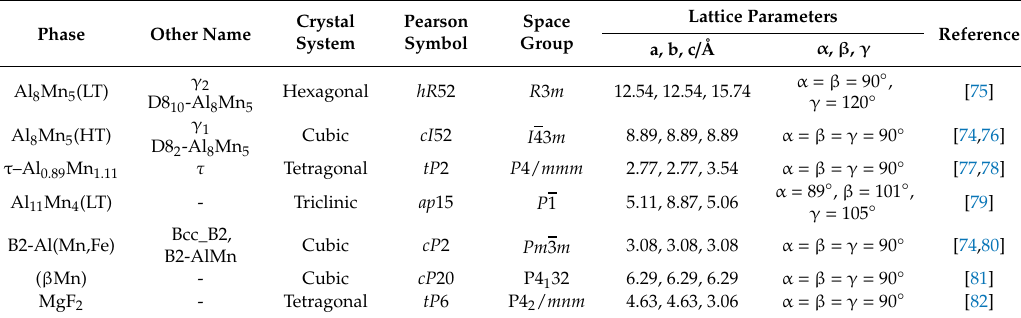
Table 2. Crystal structure of some crucial phases in the present study.